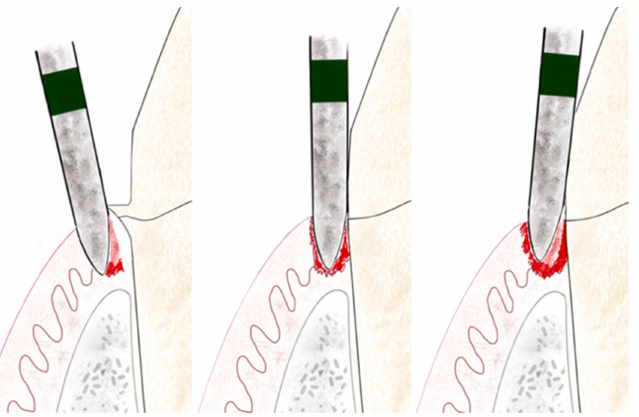
Figure 3. Illustration of BOPT 3-step preparation protocol. The left figure shows the first step, the middle one shows the second step and, on the right, the third